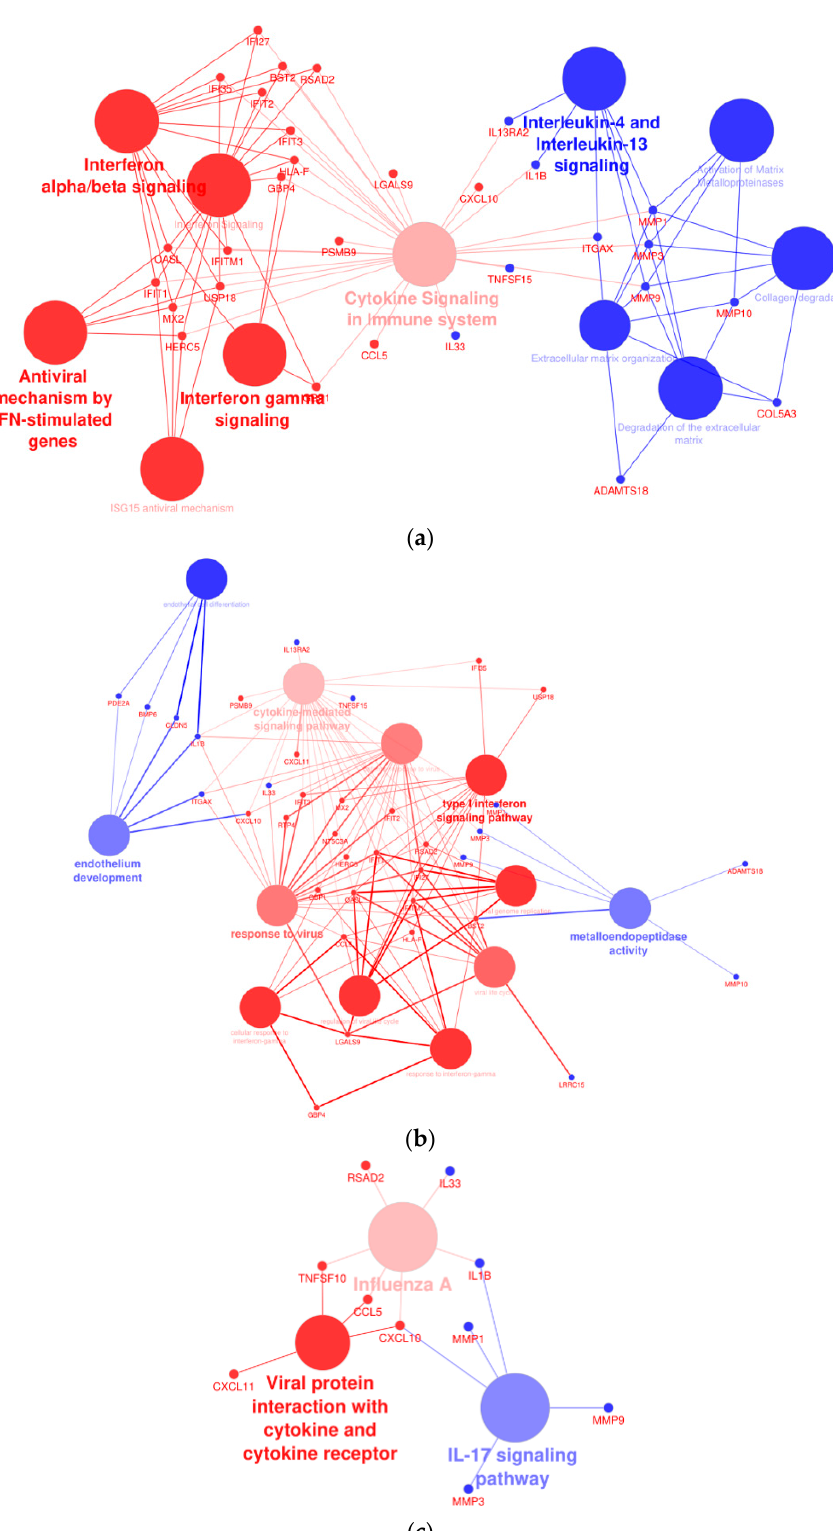
Figure 10. Cytoscape-ClueGo gene network interaction analysis, up- (blue) and down-regulated (red) genes. ( a ) Overexpression of BRAF V600E in THLE-2 cells influences the interferon- and metalloproteinase-dependent signaling pathways. ( b ) Analysis pointed out dysregulation of genes involved in the endothelium development and viral response. ( c ) An enhancement of IL-17 signaling pathway with attenuation of gene expression in response to viral infection and cytokine